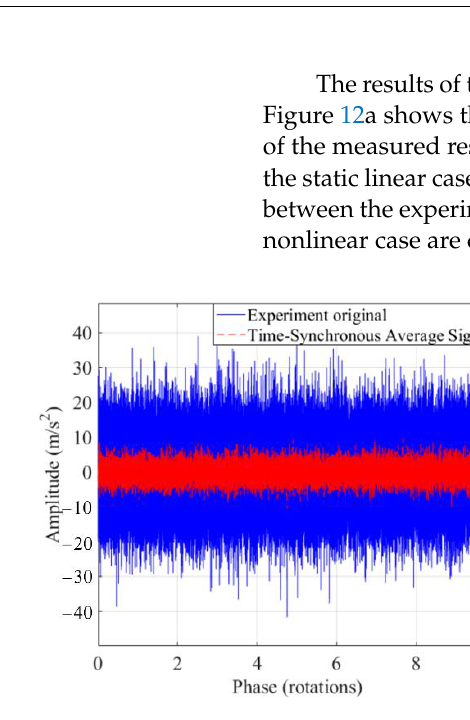
Figure 11. Vibration RMS comparison between simulated results and experimental results: ( a ) time- history vibration response; ( b ) boxplot.